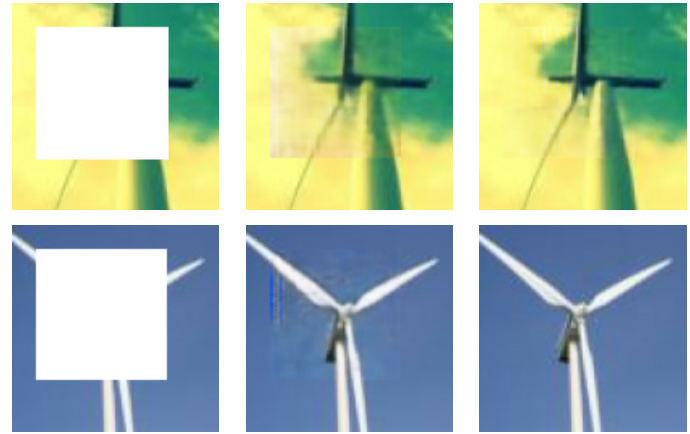
Figure 10. The results comparison of Iizuka’s method and ours with Places2 dataset.